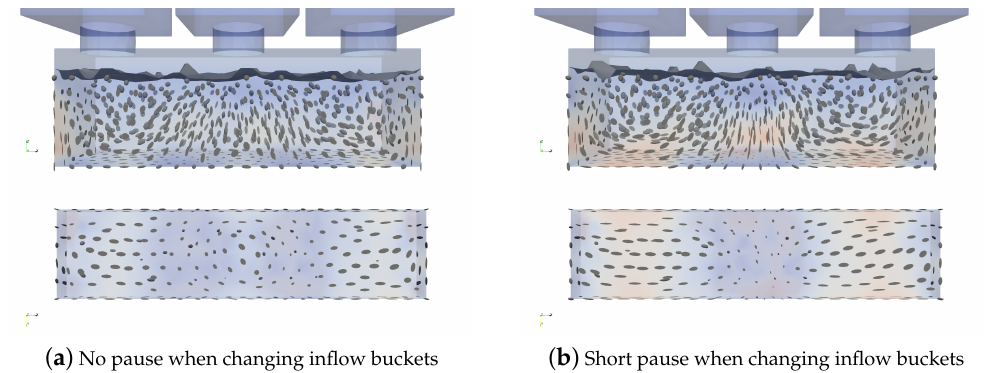
Figure 7. Comparison of a super-liquid casting with no pause between center and side castings with one having a few seconds pause between the center and the side castings to let the concrete mass settle a